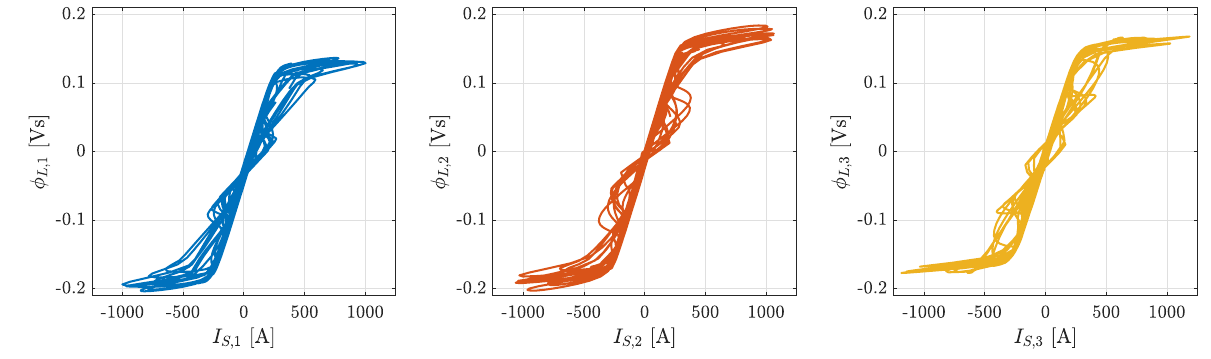
Figure 19. C2—Hysteresis loop of reactor.